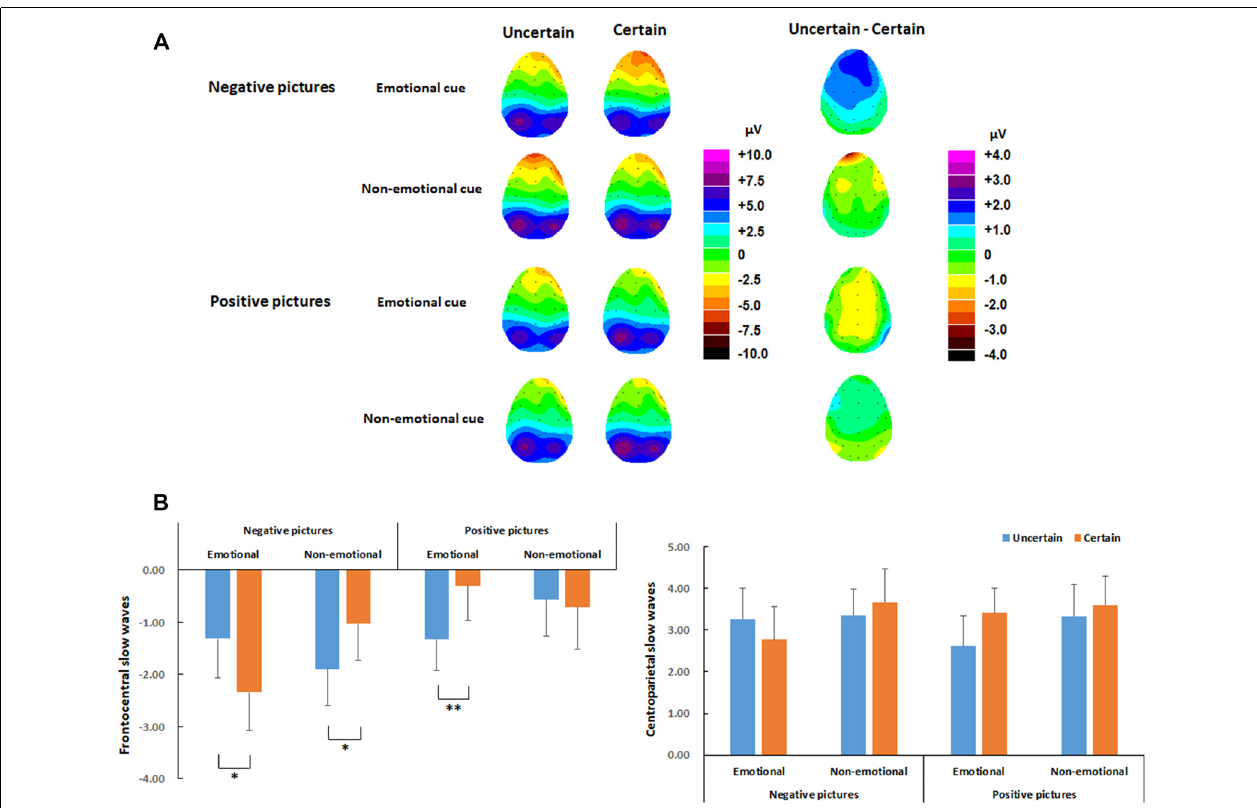
FIGURE 5 | (A) Topographical maps based on the mean amplitudes of frontocentral and centroparietal ERPs (60–1,000 ms) for the pictures for each experimental condition and the differences between the uncertain and certain conditions given each cue valence and emotion. (B) The means and SE values of amplitudes regarding frontocentral and centroparietal ERPs for the pictures in each experimental condition. See the meaning of “ ∗ ” in the caption of Figure 2